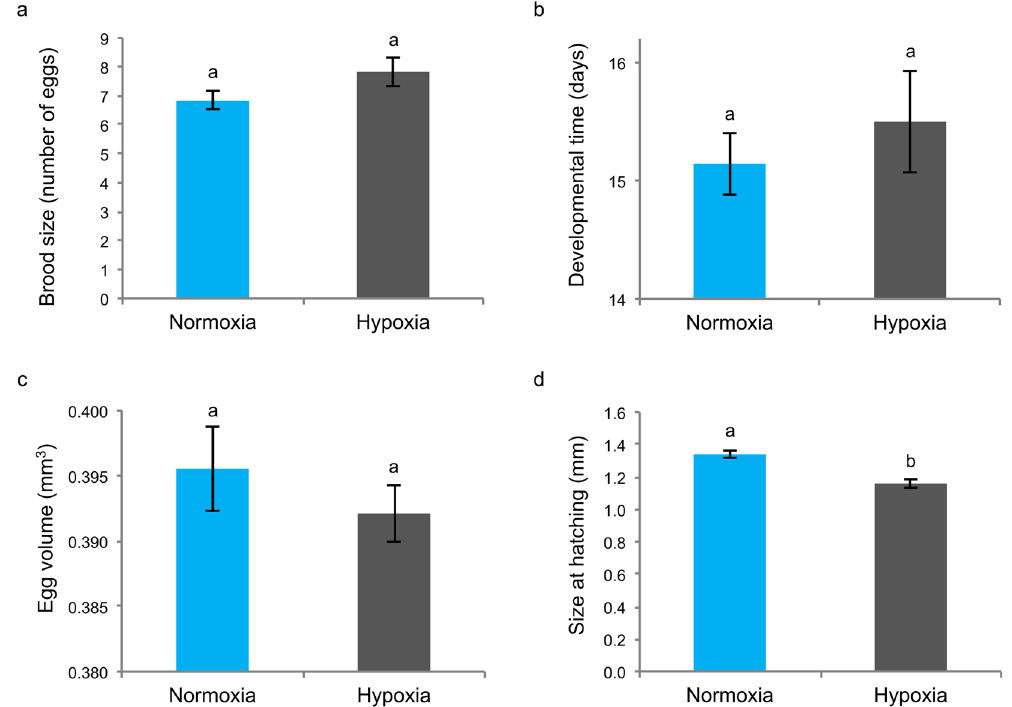
Figure 3. Effect of moderate hypoxic exposure (40% air saturation) on measures of fitness in Gammarus chevreuxi . ( a ) Brood size, ( b ) developmental time, ( c ) egg volume and ( d ) size at hatching in F 1 individuals under normoxia (100% air saturation) and hypoxia (40% air saturation). Values are expressed as mean ± s.e.m. Letters above bars indicate significant differences between groups ( P <